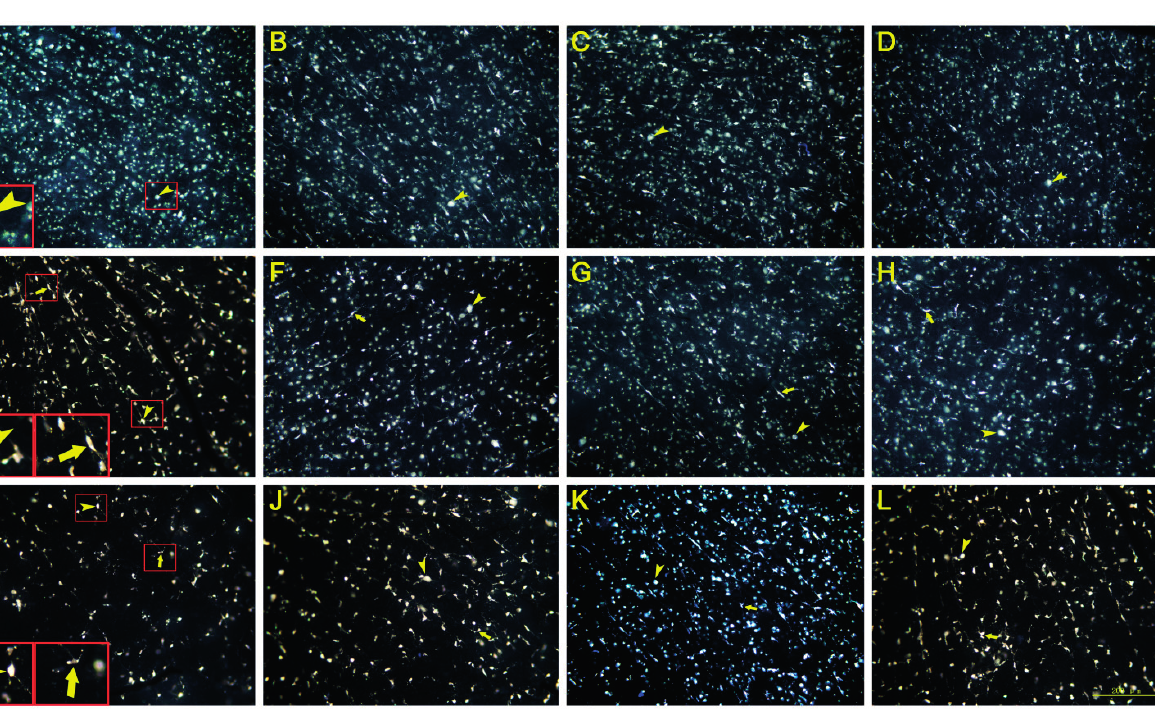
Figure 1. Photomicrographs of surviving retinal ganglion cells (RGCs) retrogradely-labeled with FG in Control 2 days ( A ), 7 days ( E ) and 14 days ( I ) groups; 30 mg/kg·bw LiCl 2 days ( B ), 7 days ( F ) and 14 days ( J ) groups; 60 mg/kg·bw LiCl 2 days ( C ), 7 days ( G ) and 14 days ( K ) groups; and 85 mg/kg·bw LiCl 2 days ( D ), 7 days ( H ) and 14 days ( L ) groups ( n = 6 for each group). RGCs have large circular cell bodies with clear boundaries (arrow heads). A few glial cells with smaller irregular bodies and short branched processes are also visible in the retina (arrows). Bar = 200